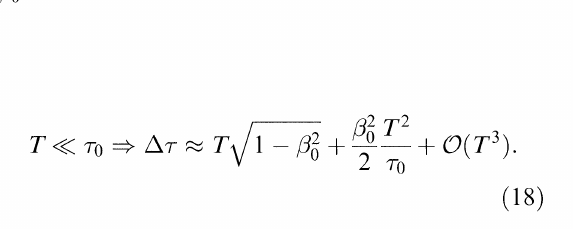
The function Ar(T/ro)/ro versus T/ro. Four typ- ical cases are shown (/3o 0,/3o 0.7,/3o 0.9,/3o 1). All pos- sible curve lines are between the graphs of/3o 0 and /3o--1. The dashed line indicates the asymptotic behavior of the case /30